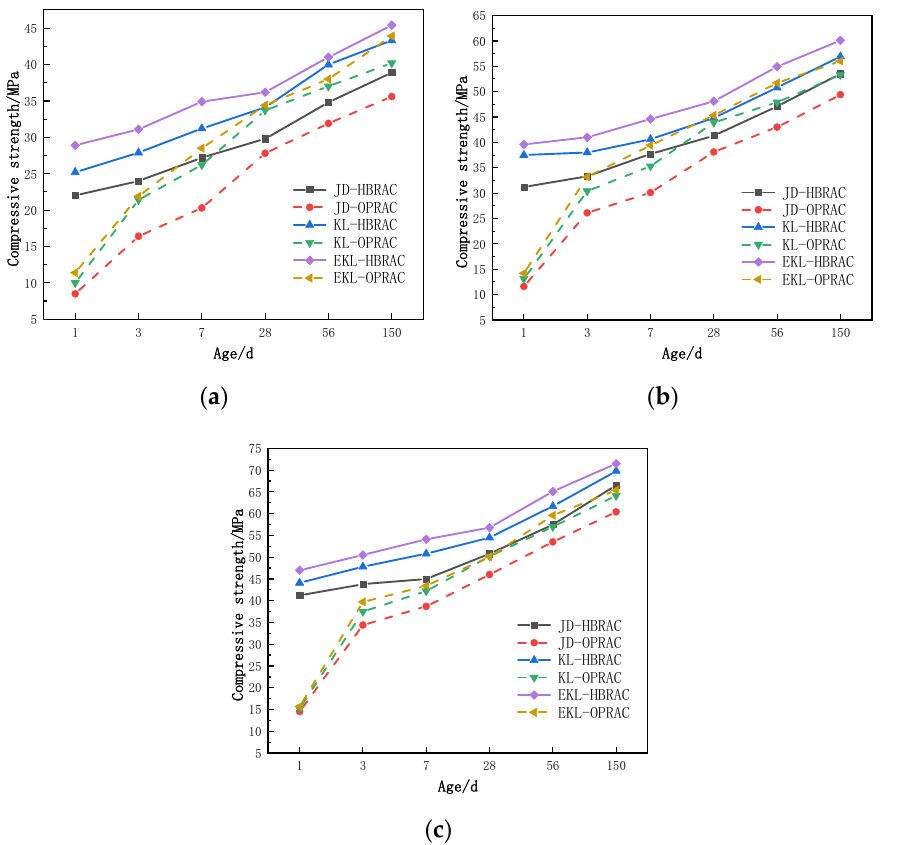
Figure 6. Comparison of compressive strength of HBRAC and OPRAC at different ages: ( a ) cementitious material content 300 kg/m³, ( b ) cementitious material content 400 kg/m³, and ( c ) cementitious material content 500 kg/m³.